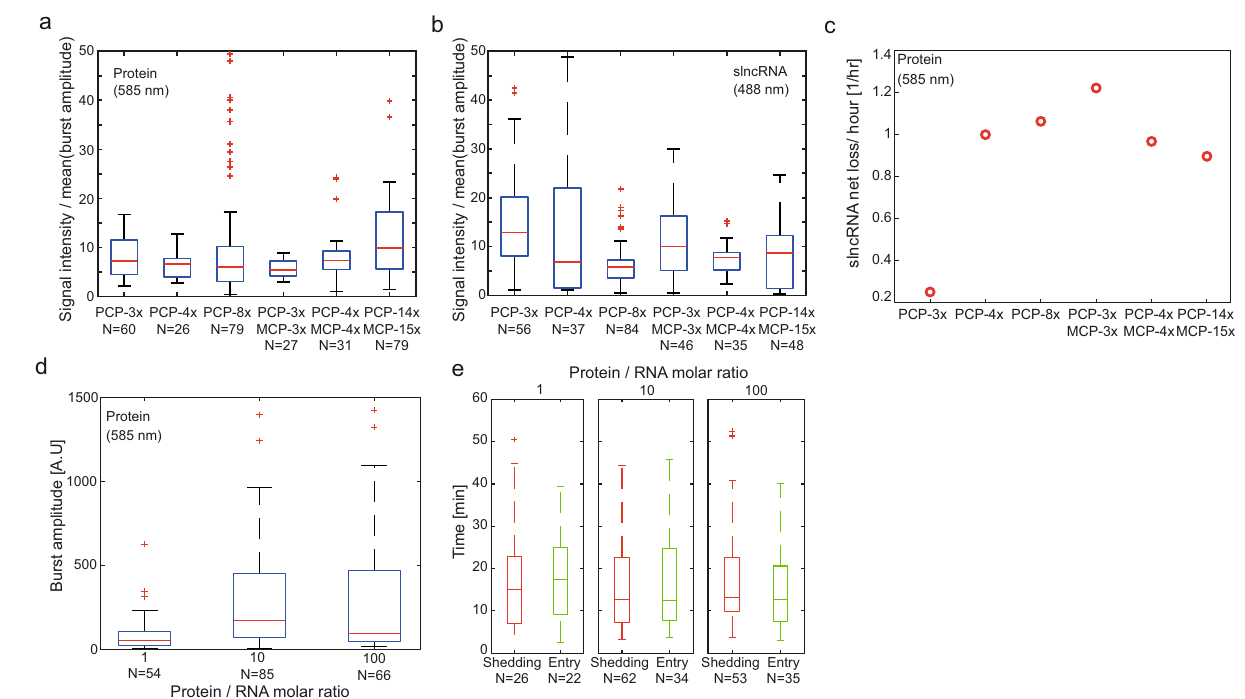
Fig. 5 | Granules act as protein capacitors. a Boxplots depicting ratio between granule protein fl uorescence and median burst amplitude, providing a measure of theproteincontentinsidethegranules. b Boxplotsdepictingratiobetweengranule slncRNA fl uorescence and mean burst amplitude providing a measure of the slncRNA content inside the granules. c Rate of net slncRNA loss for each granule type,showing adifferenceintrendbetweenclassIand classIIslncRNA. d Boxplots depictingburstamplitudesmeasuredfromgranuleswithdifferentratiosofprotein to slncRNA. Granules formed with ratio of 10:1 and 100:1 appear to have similar